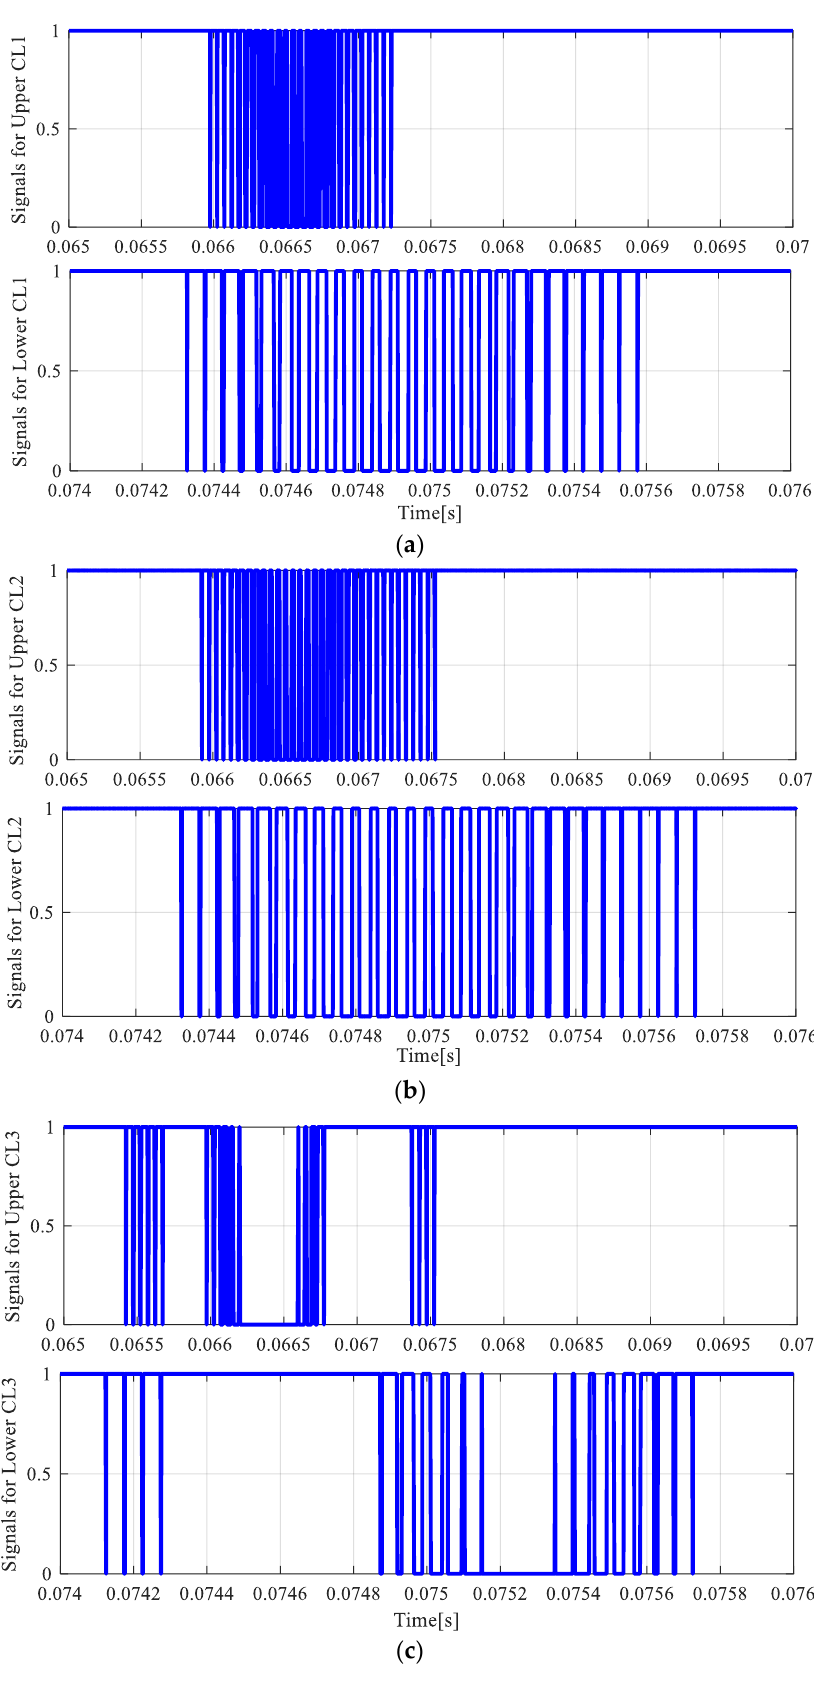
Figure 7. The signals of upper and lower switches of the MMC for the ( a ) first controller, ( b ) second controller, and ( c ) third controller.